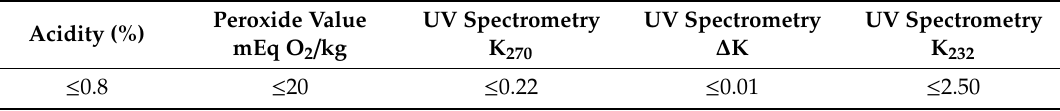
Table 1. Limit values for the physico-chemical characteristics for EVOO category in Regulation (EU) No 1348 / 2013 that amends Regulation (EEC) No 2568 /